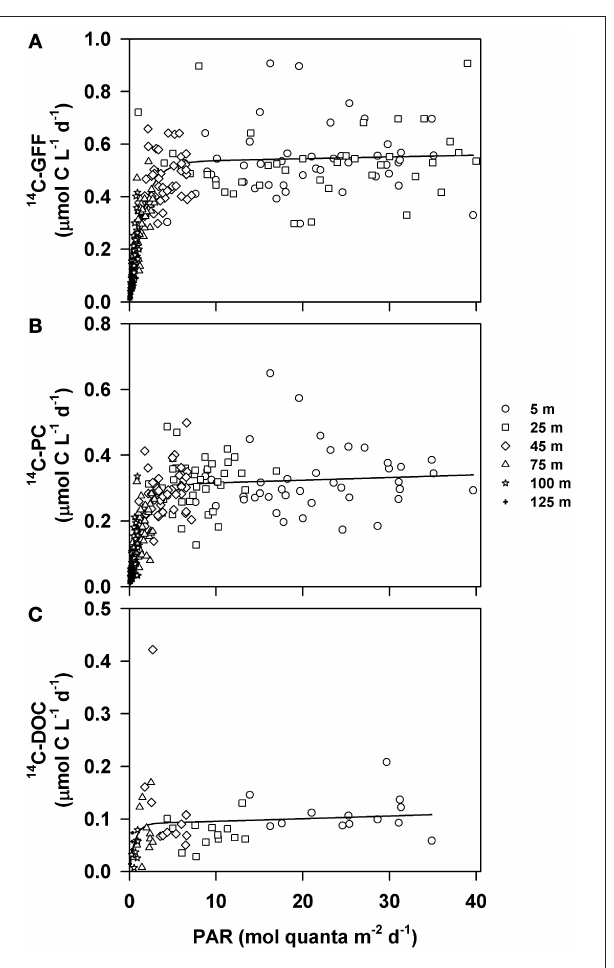
FIGURE 5 | Relationships between downwelling photosynthetically active radiation (PAR) and rates of (A) 14 C-GFF; (B) 14 C-PC; and (C) 14 C-DOC. Circles represent data points collected from 5 m, squares from 25 m, diamonds from 45 m, triangles from 75 m, stars 100m and crosses from 125 m. Lines depict least-squares regression fits to the measured production rates and PAR using the Platt et al. (1980) formulation. Parameters describing the regression fits are provided in Table 2